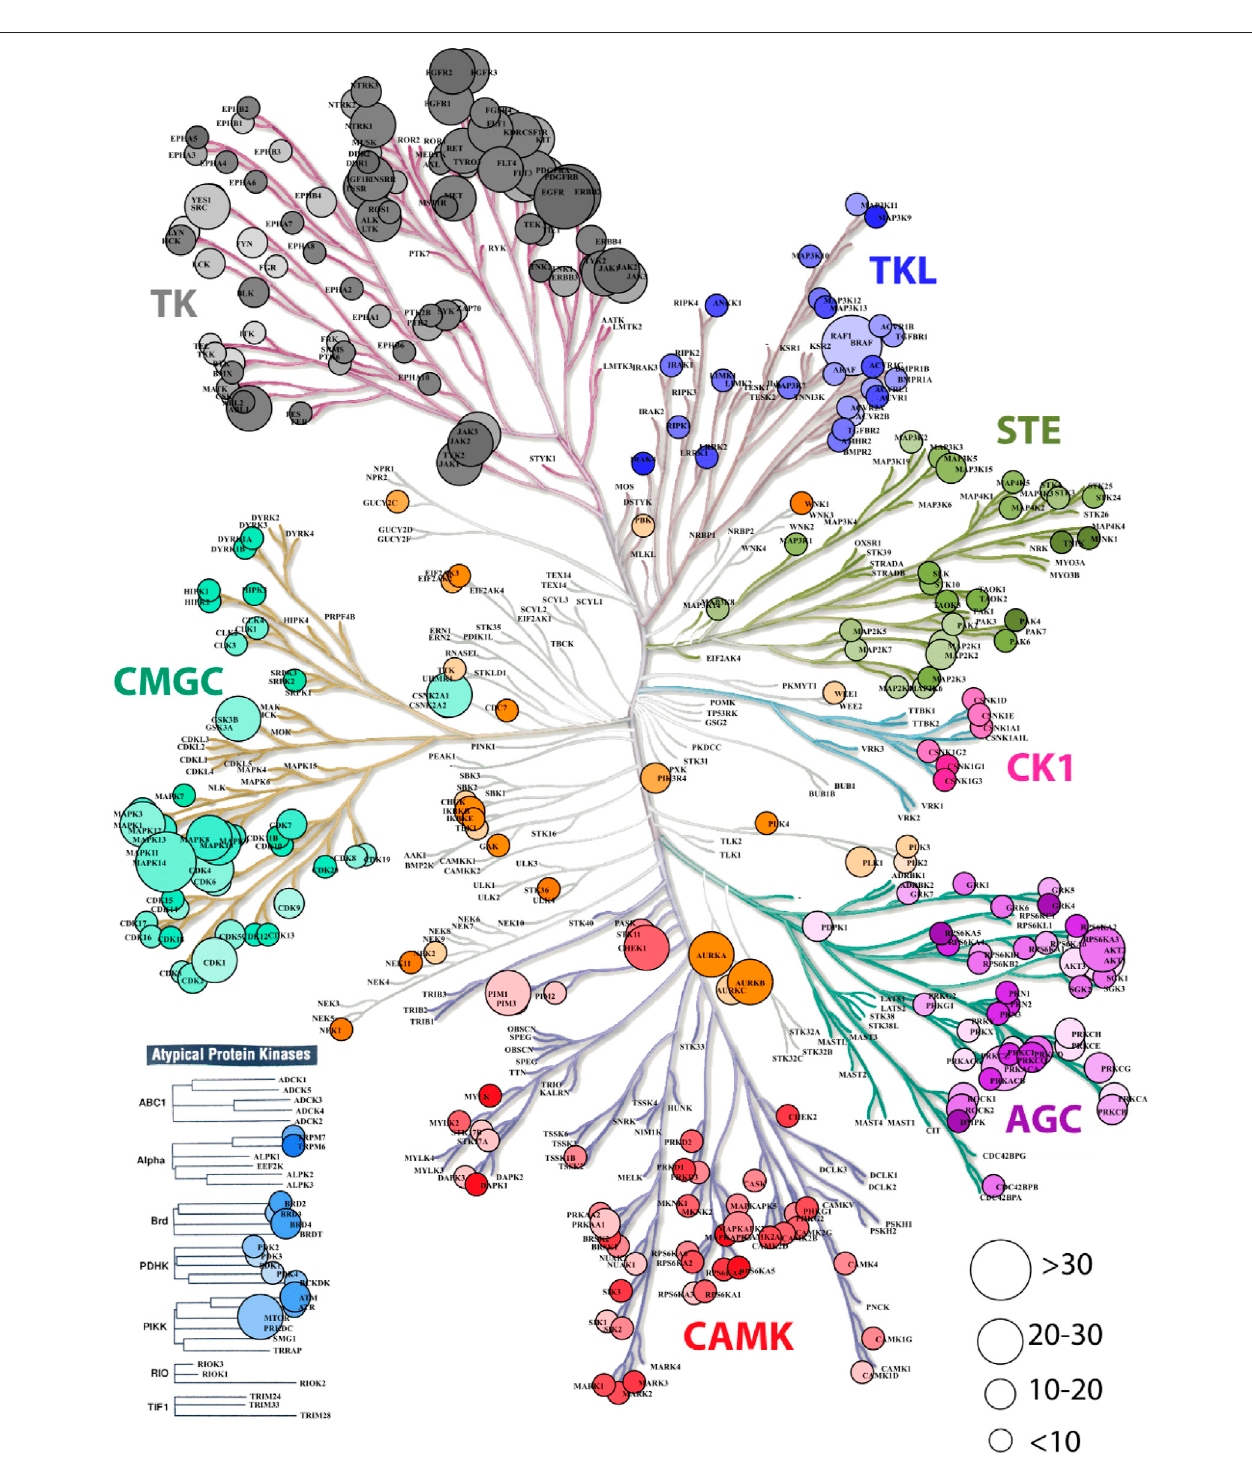
FIGURE1| DendrogramrepresentationkinasecodinggenesinIndiGen datausingKinMapbeta.Thecirclesizerepresentsthenumberofdrugmoleculesavailable for a gene with known drug-gene interaction. The class of kinase is highlighted with a unique color and the color gradient in each data circle represents the number of variations present in IndiGen data for that